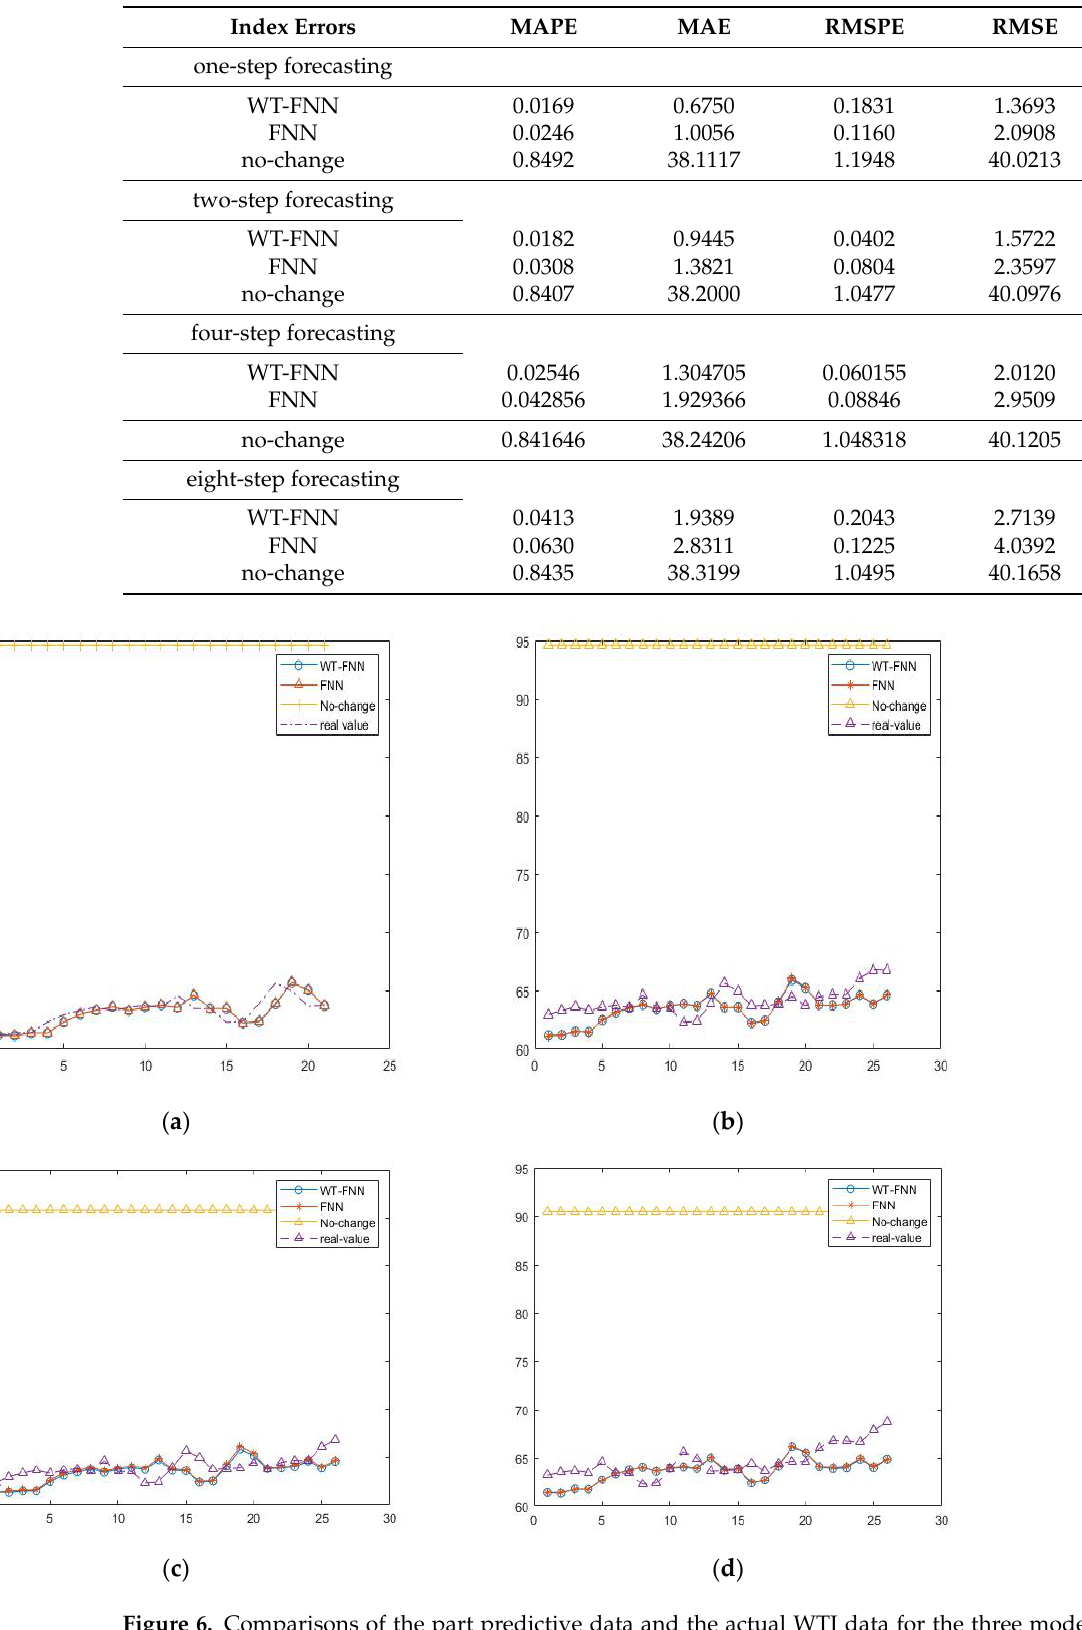
Table 4. Comparisons of predictions from different forecasting models for WTI.